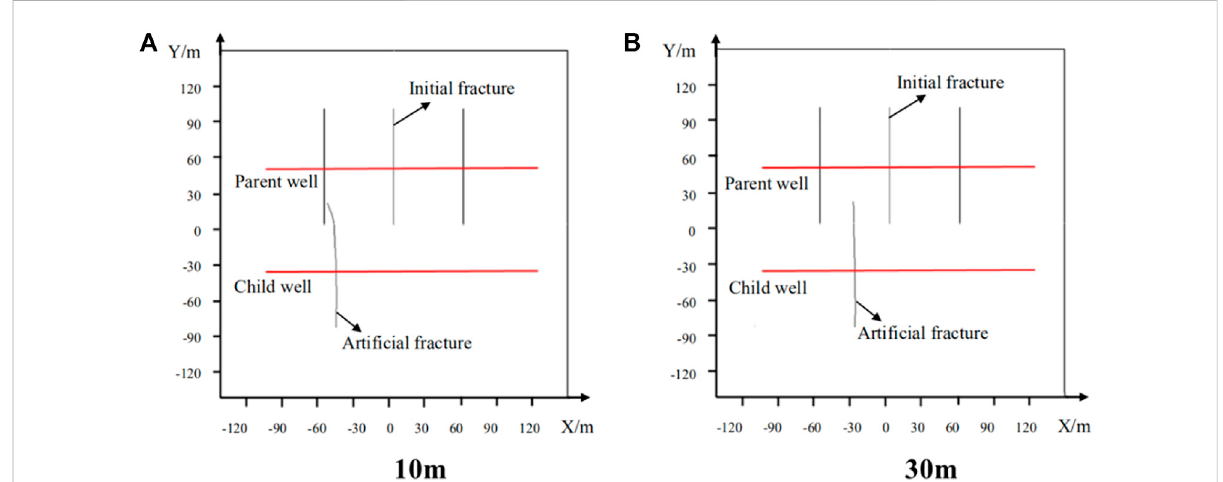
FIGURE 6 The propagation trajectory of a single arti fi cial fracture at different positions.